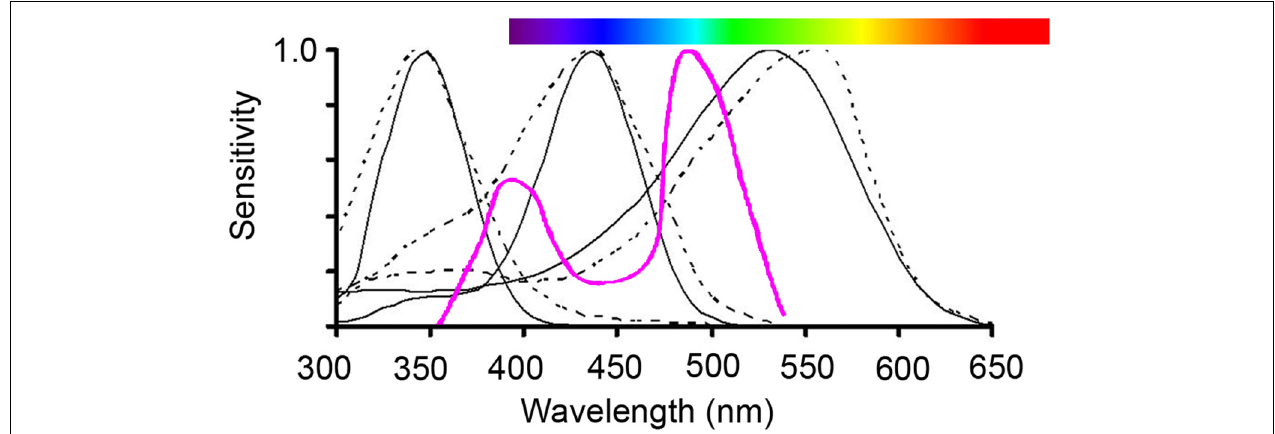
FIGURE 5 | Illustration of trichromatic vision of important hymenopteran pollinators, bumblebees (solid line) and honeybees (dotted line), which have photoreceptor sensitivities peaking in the UV range (about 350 nm), in the blue range (about 440 nm) and in the green range (540 nm). Human color vision is given as a reference above in the horizontal spectral visible bar. The purple line (inverted (cid:49) λ / λ function for the honeybee; von Helversen, 1972; Chittka and Menzel, 1992) presents the two regions (400 nm and 500 nm), where spectral sensitivity curves overlap and therefore color discrimination can be expected to be highest. Graph reproduced from Shrestha et al.